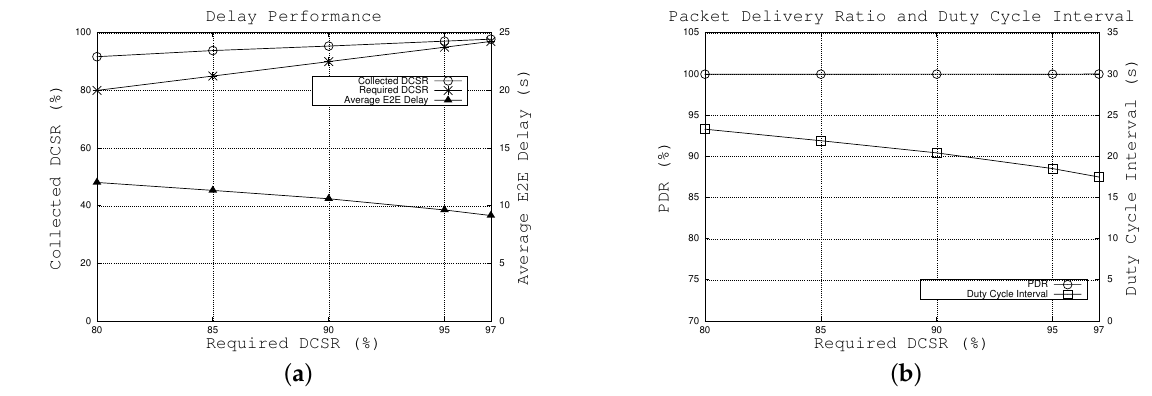
Figure 4. Effects of required DCSR. ( a ) effects on achieved DCSR and average E2E delay, ( b ) effects on packet delivery ratio and duty cycle interval.